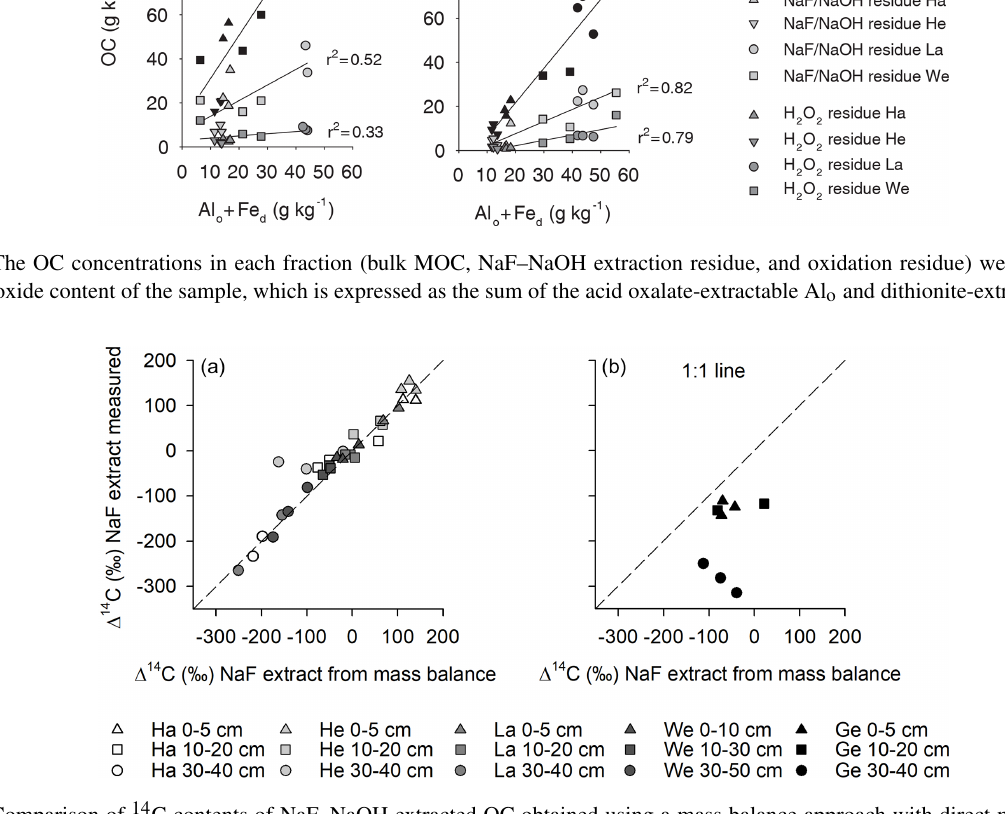
Figure 4. Comparison of 14 C contents of NaF–NaOH extracted OC obtained using a mass balance approach with direct measurements of the extracts after dialyses for (a) Hainich (Ha), Hesse (He), Laqueuille (La), and Wetzstein (We), and (b) Gebesee